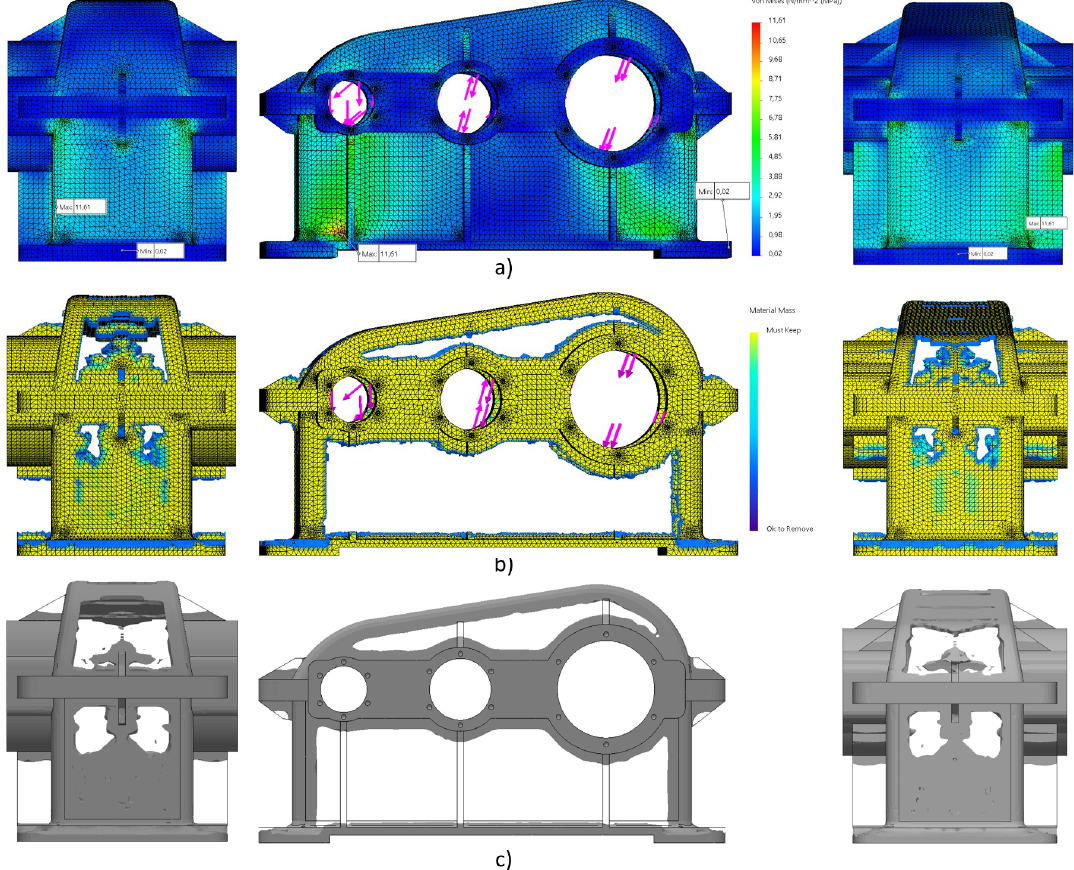
Figure 7. ( a ) Views of resultant stress plot obtained from a preliminarily carried out static study of the 3D model; ( b ) views of the material mass plot after topology optimization; ( c ) views of the smoothed surface mesh of the topology optimized model.